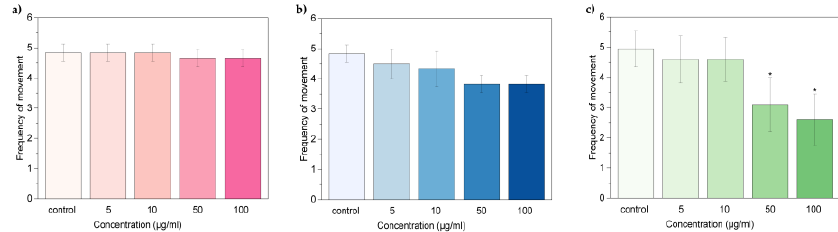
Figure 7. Frequency of movement of zebrafish larvae exposed to ( a ) oxi-CNOs, ( b ) CNHs and ( c ) GO. Values are expressed as means ±S.D